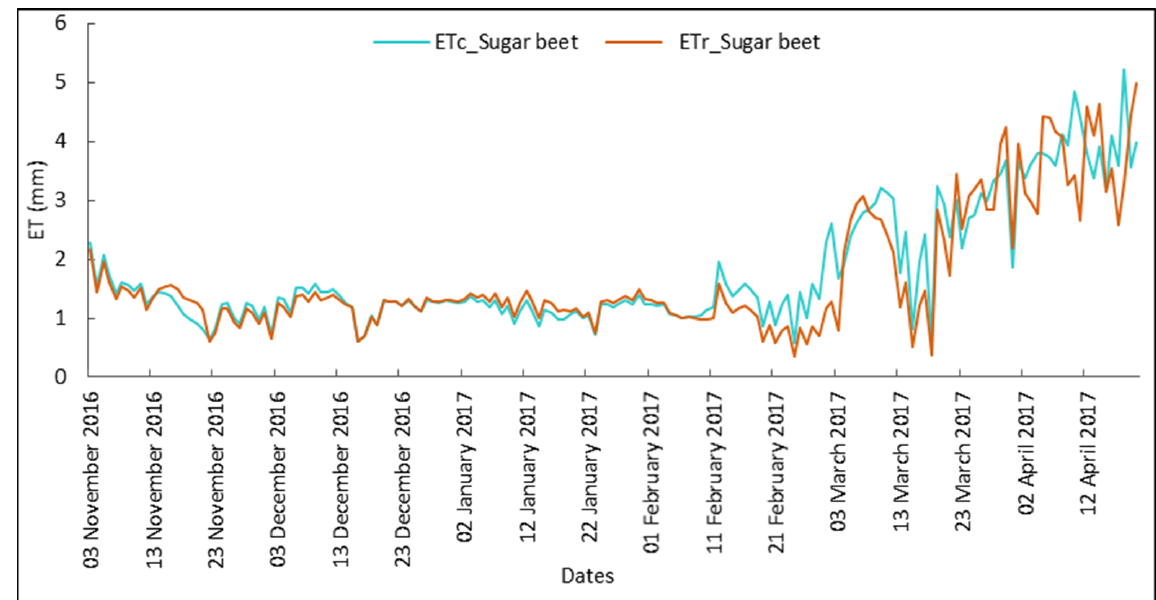
Figure 13. Comparison between ETc and ETr for sugar beet crops .